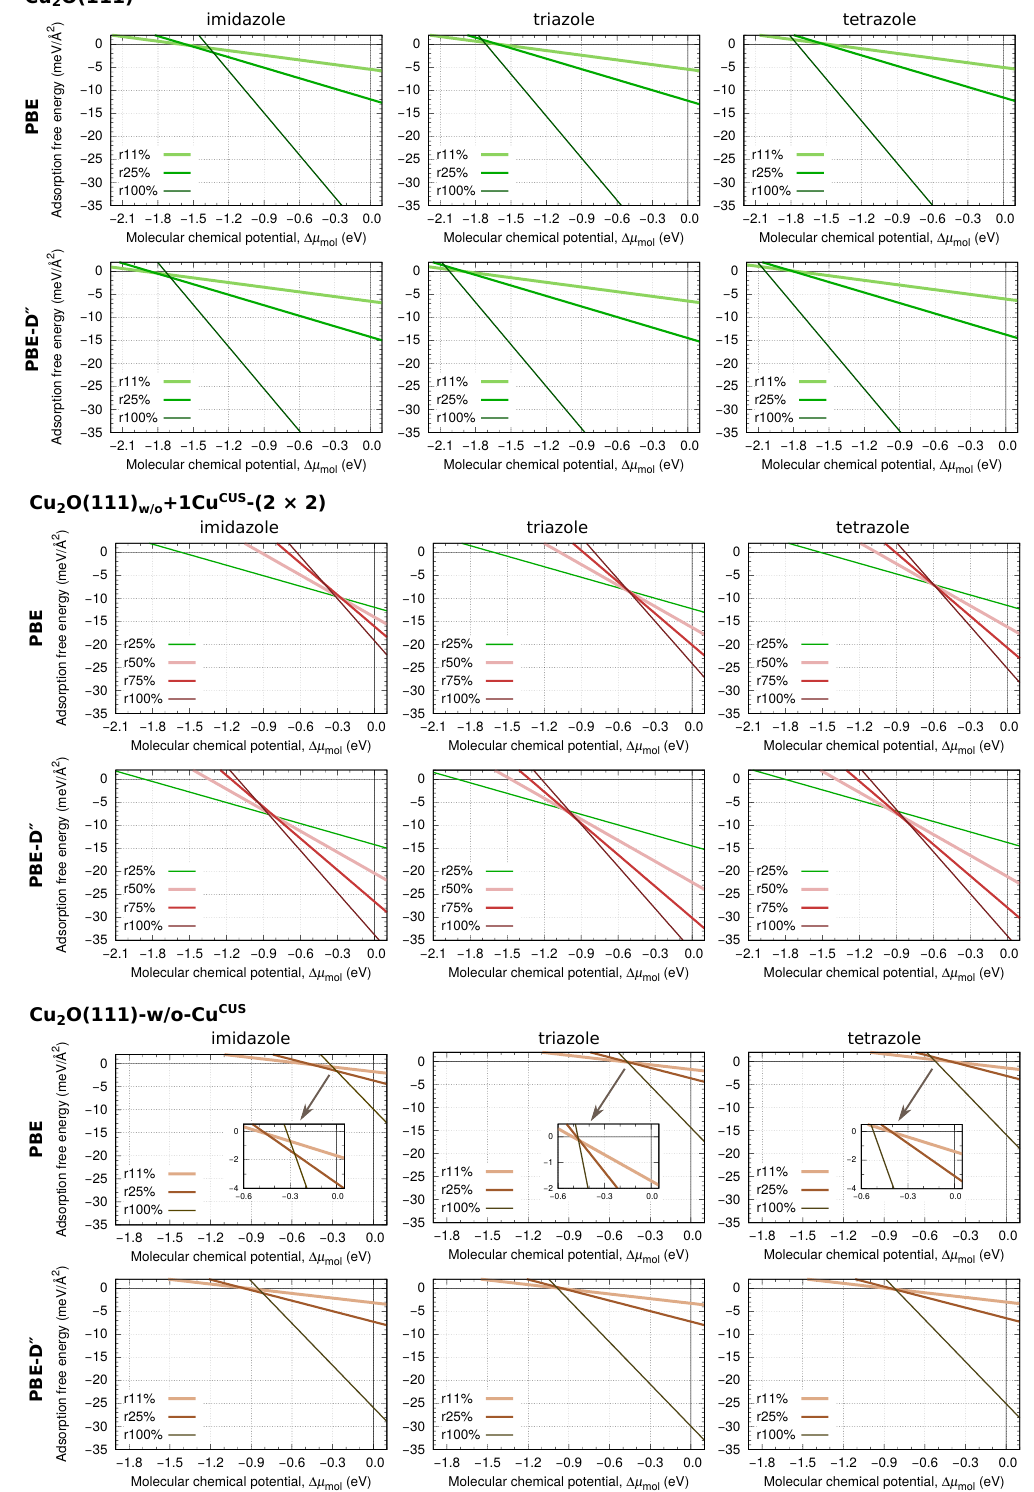
Figure A4. PBE and PBE-D (cid:48)(cid:48) calculated adsorption surface free energies as a function of the molecular chemical potential, γ ads of Equation (11), for imidazole ( left) , triazole ( middle ), and tetrazole ( right ) on Cu 2 O(111) ( top ), Cu 2 O(111) w/o +1Cu CUS –(2 × 2) ( middle ) and Cu 2 O(111)-w/o-Cu CUS ( bottom ) surfaces. Only the preferred non-dissociative adsorption modes are